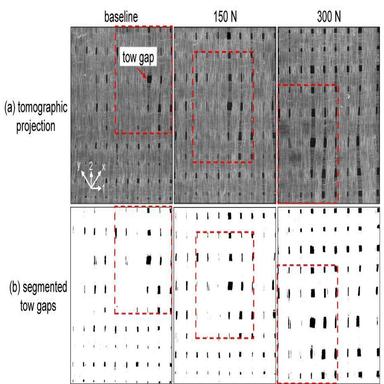
Evolution of tow gaps with the applied 1:1 biaxial load. (a) Projection of tomographic stacks into high contrast standard-deviation images. (b) Segmentation of tow gaps using grayscale thresholding. The orange dashed boxes define an ROI that can be seen in all three data sets. (For interpretation of the references to color in this figure legend, the reader is referred to the Web version of this article.)